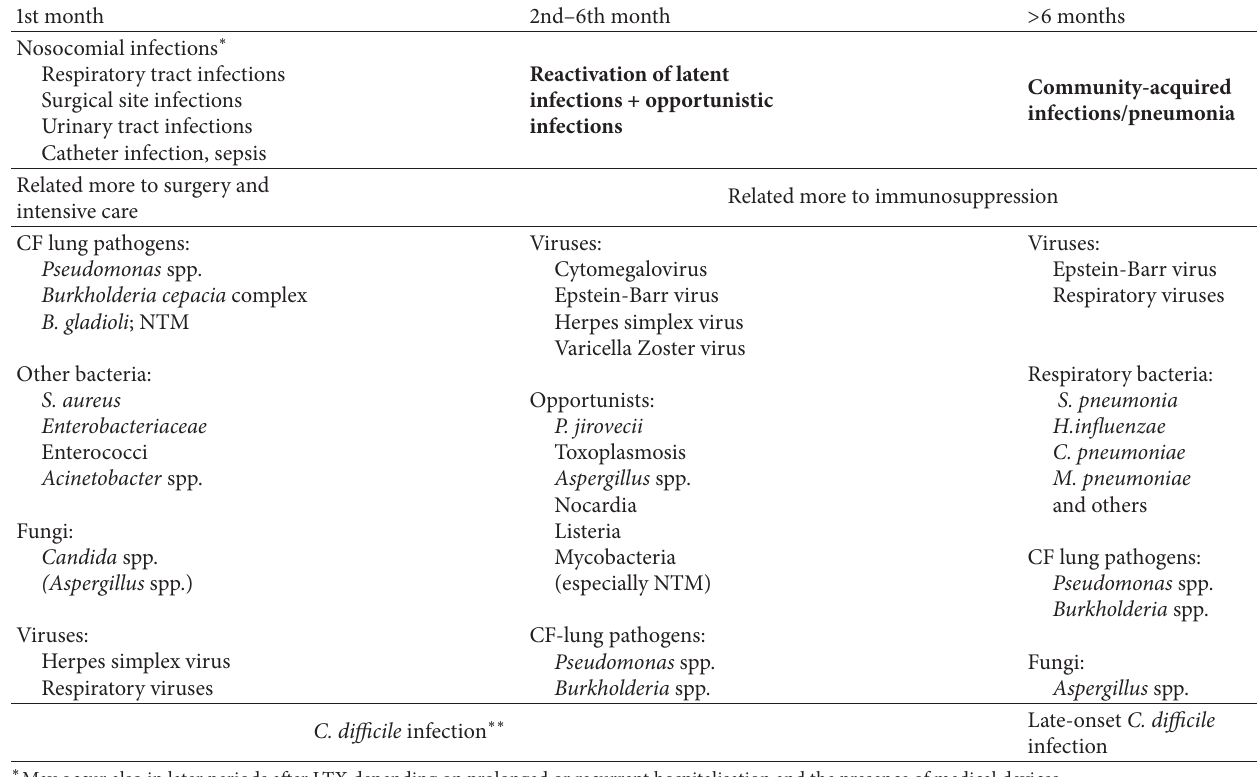
Table 5: Timetable of infections following